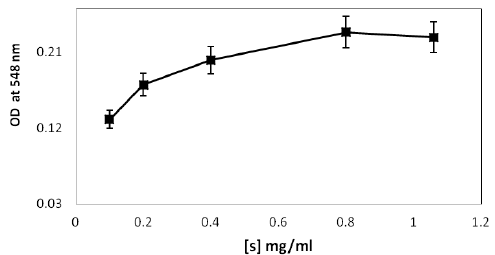
Fig. 1. The effect of different substrate concentrations in the enzymatic activity of AlgL. Reaction mixture containing a crude enzyme preparation from P.aeruginosa strain 214 and each of different substrate concentrations was incubated at 37°C and the enzyme activity was determined.